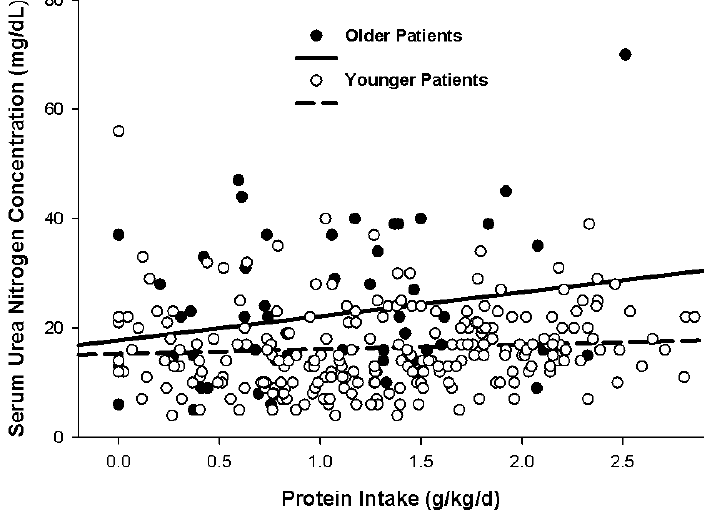
Figure 4. Variability in serum urea nitrogen concentration at different protein intakes. The linear correlative relationship between serum urea nitrogen concentration and protein intake was r = 0.500 ( p < 0.001) and r = 0.482 ( p < 0.001) for older and younger patients, respectively. Analysis of covariance indicated no significant difference ( p = N.S.) in the slopes between the age groups. Reprinted with permission from Dickerson, R.N.; Maish, G.O., 3rd; Croce, M.A.; Minard, G.; Brown, R.O. Influence